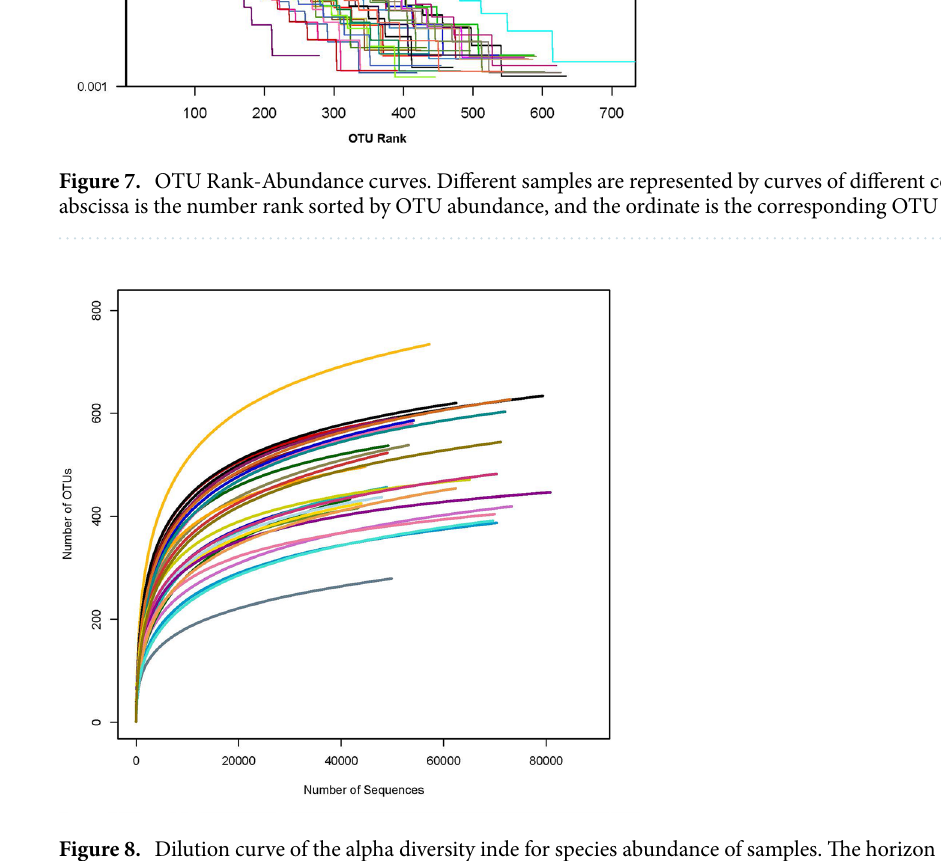
Figure 8. Dilution curve of the alpha diversity inde for species abundance of samples. The horizon axis represents the number of clean reads randomly extractrd from a sample, and the vertical axis represents the